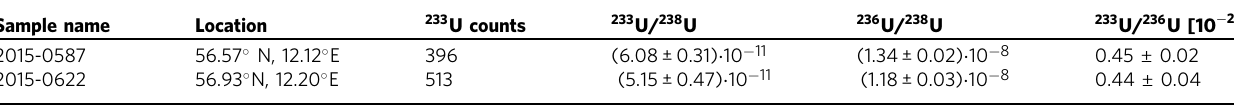
Table 2 236 U/ 238 U, 233 U/ 238 U and 233 U/ 236 U results for two selected samples collected at the strait between Denmark and